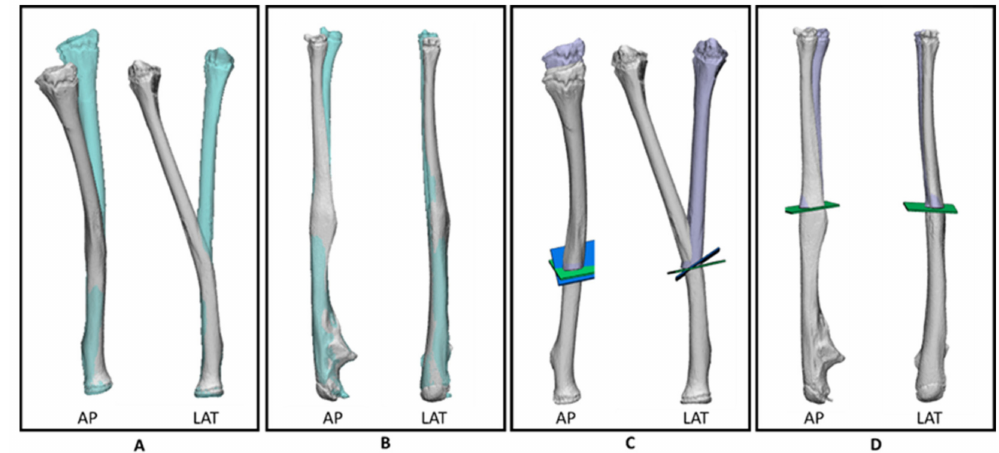
Figure 2. 3D models based on the preoperative CT scan in anterior posterior (AP) and lateral (LAT) position of ( A ) the injured left radius (grey) and the mirrored contralateral radius (blue), ( B ) the injured left ulna (grey) and the mirrored contralateral ulna (blue), ( C ) planned double osteotomy of the radius where the green and blue planes represent the first and second sawing planes, respectively. After correction, the injured radius (grey) can be repositioned towards the desired (purple)